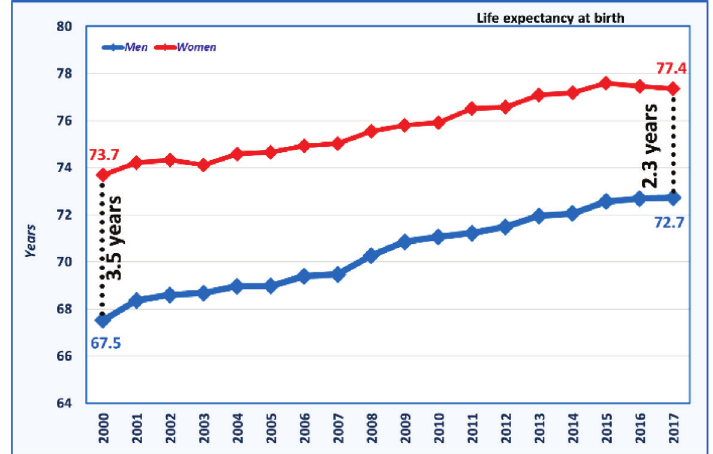
Figure 15. Life expectancy at birth in Azerbaijan. Source: author’s